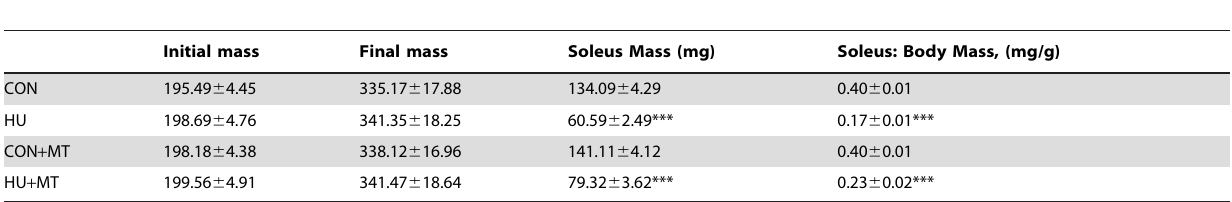
Table 1. Body mass (g), soleus mass (mg) and soleus:body mass ratio (mg/g) of rats from control, mitoTEMPO-treated